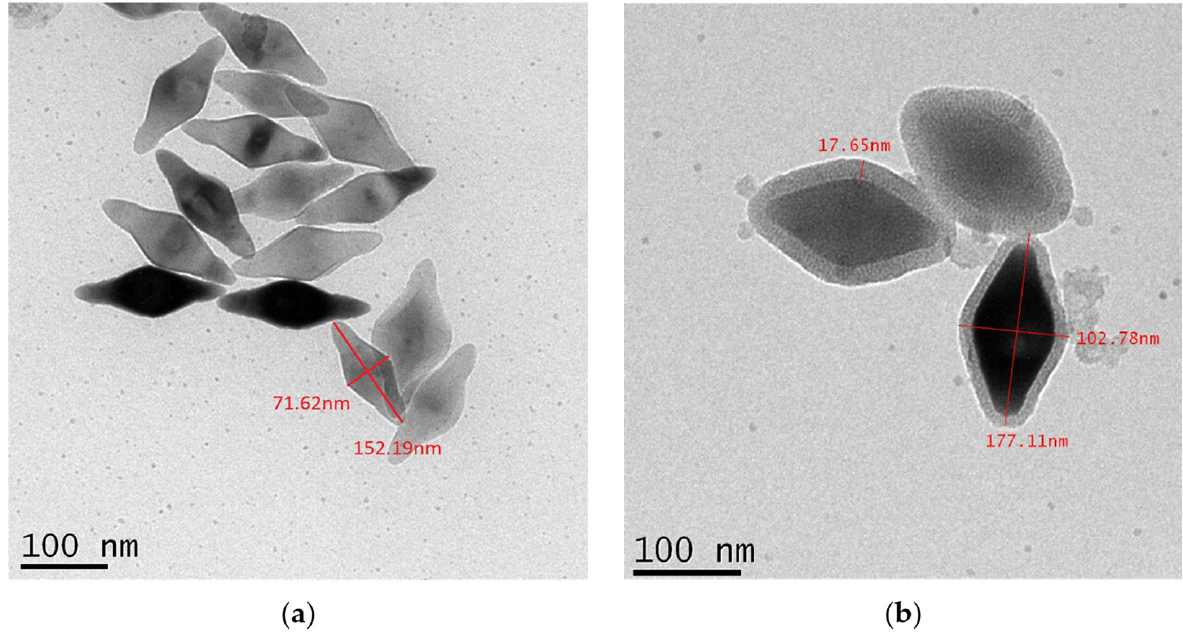
Figure 3. TEM images of LiYF 4 :Yb 3+ 0.25 ,Er 3+ 0.01 @LiYF 4 :Yb 3+ 0.2 UCNPs. ( a ) Ligand-free nanoparticles; ( b ) mSiO 2 -coated nanoparticles.